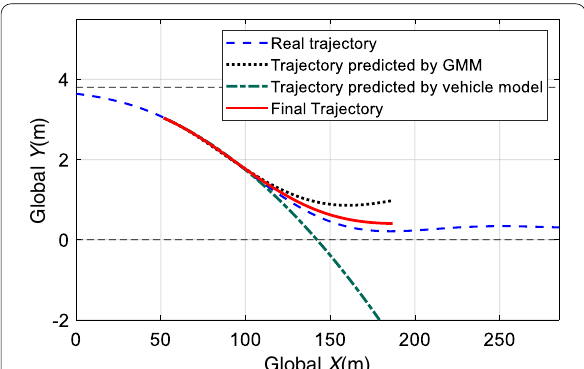
Figure 6 Trajectory prediction at 1.4 s after the start of lane change